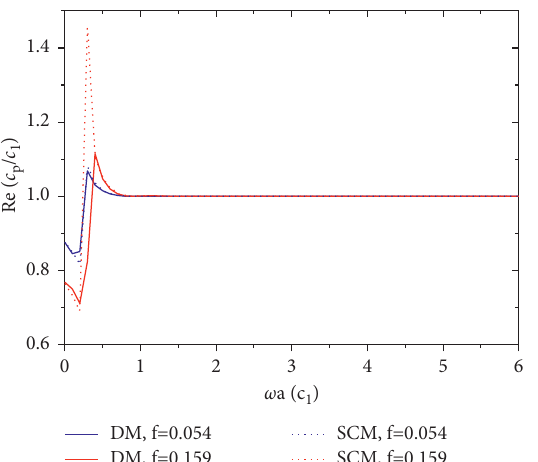
Figure 6: Comparison of ratios of the phase velocity in the composite material and matrix obtained by the differential method (DM) and self-consistent method (SCM) when quasi-P wave propagates in the composite material for inclusion volume fraction of 5.4% and 15.9% and δ � 5.